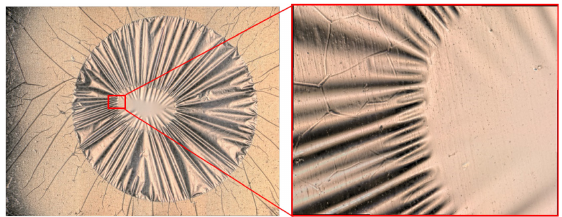
Fig. 7. Surface structure after Ar + beam irradiation, as observed using digital